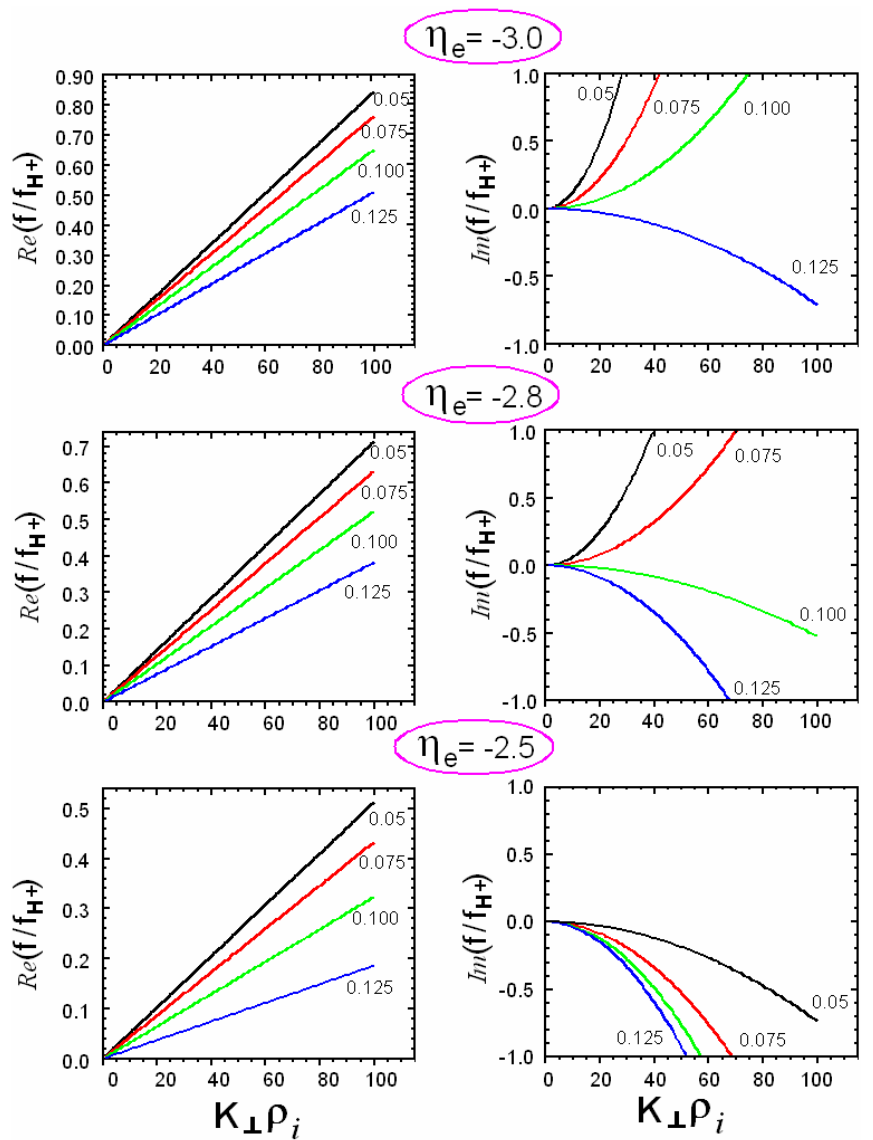
Fig. 9. Real and imaginary part of the normalized frequency versus k ⊥ ρ i , for 0 . 05 < k // ρ i < 0 . 125. The inhomogeneity is now taken into account. Parameters are the same as for Fig. 7, except for inhomogeneity parameters: η e (as indicated on the figure), α = − 1 . 02 ,L N = 10 6 . For η e > − 2 . 5, waves are damped, whatever k // ρ i . For η e < − 2 . 5 large growth rates are obtained, especially for the smaller values of k // ρ i